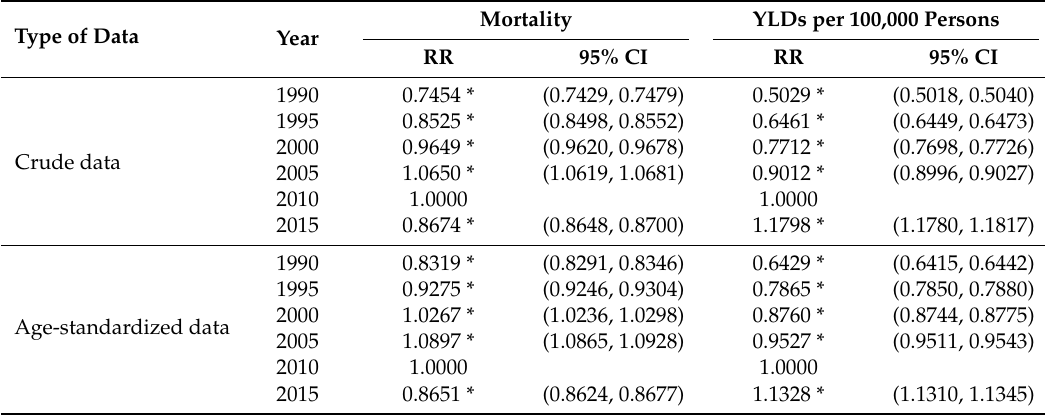
Table 2. Changes in crude and age-standardized mortality and YLDs per 100,000 persons from road traffic crashes attributed to alcohol use in China based on GBD 2015 update, 1990–2015.